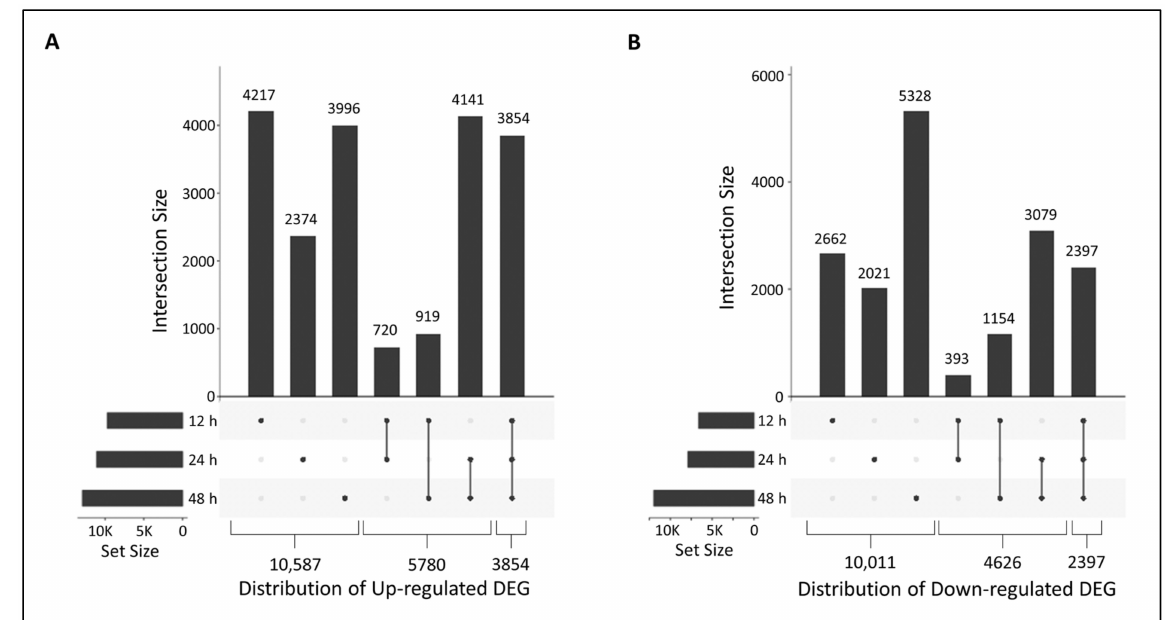
Figure 3. UpSetR plots depicting the number of unique and shared differentially expressed genes (DEGs) between control and heat/drought stressed plants at each time point. Graph depicts the number of unique, total, and shared DEGs that were ( A ) up-regulated and ( B ) down-regulated. The number above each bar represents the number of DEGs in each category. Shared categories are indicated by linked dots below the x-axis. The numbers below the chart represent the total number of DEGs present at only one, two, or all three time-points. Data sets are presented in Supplementary Tables S1 and